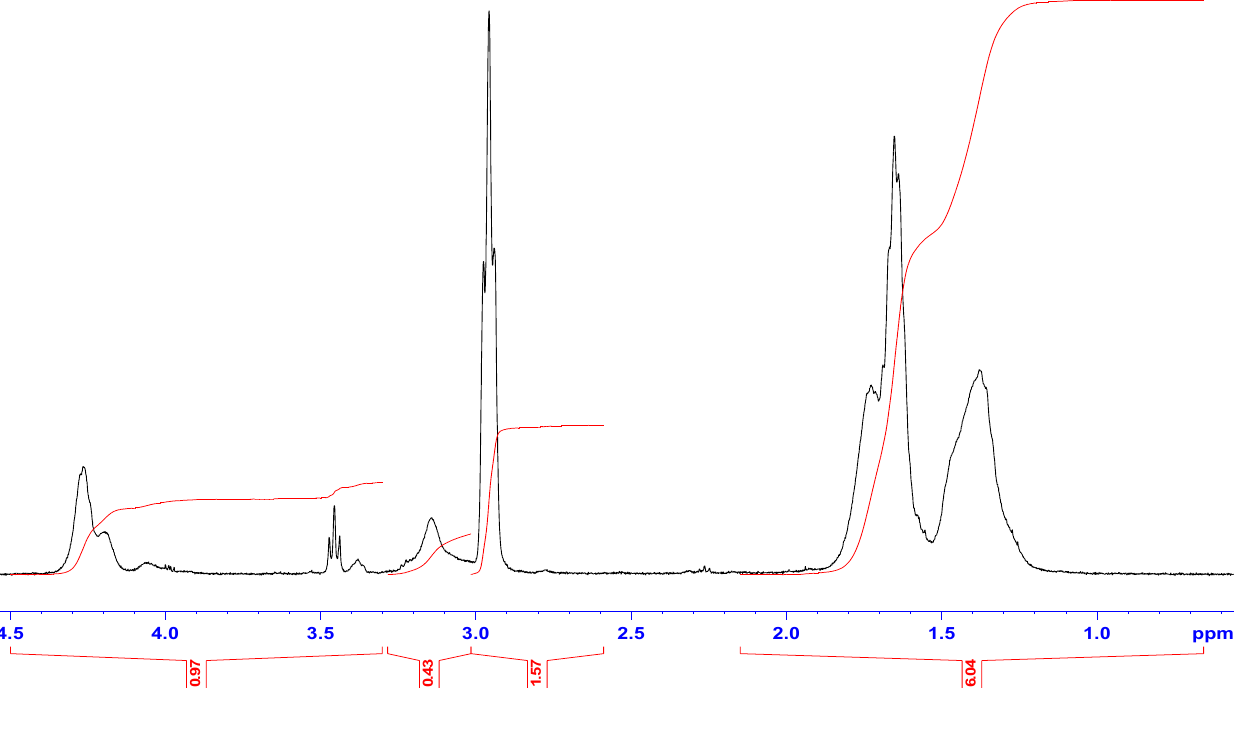
O containing 0.2 M NaCl. The peak at 4.26 2